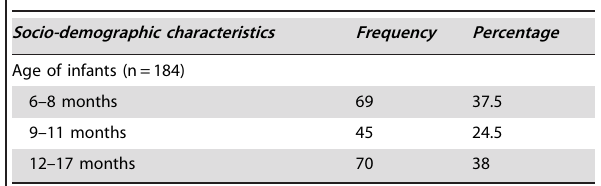
Table 1. Characteristics of HIV positive mother’s infant pairs in Sidama Zone, Southern Ethiopia,